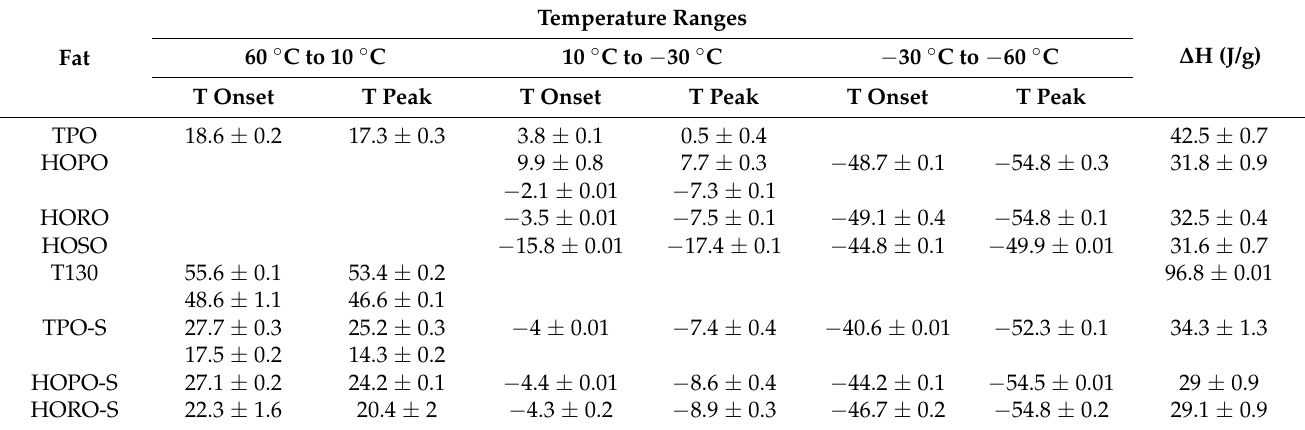
Table 6. Crystallization onset and peak temperature ( ◦ C), and enthalpy of fats ∆ H